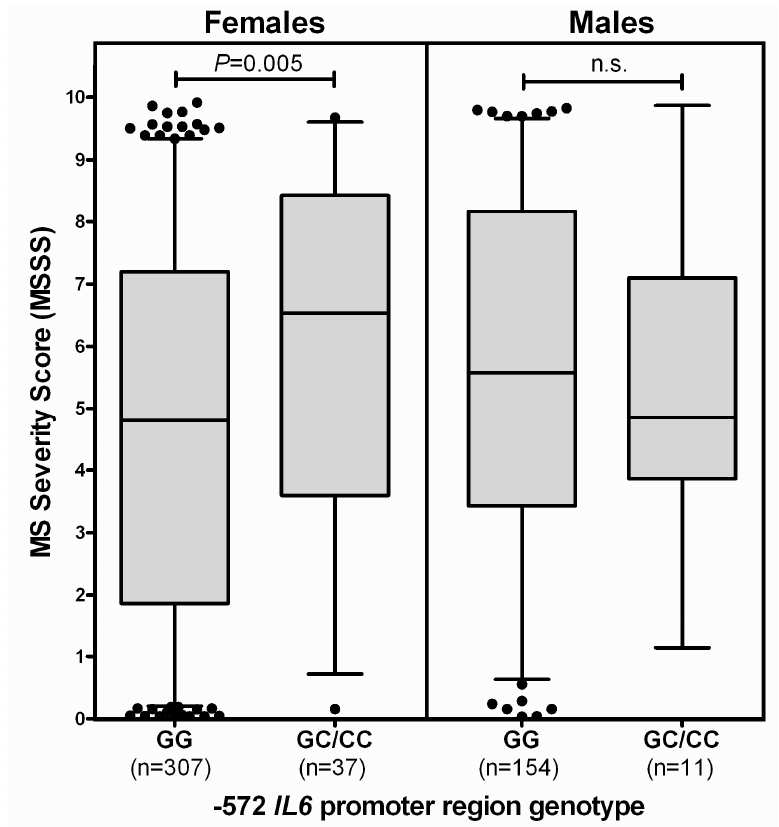
Figure 3. MS Severity Scores in females and males, by − 572 IL6